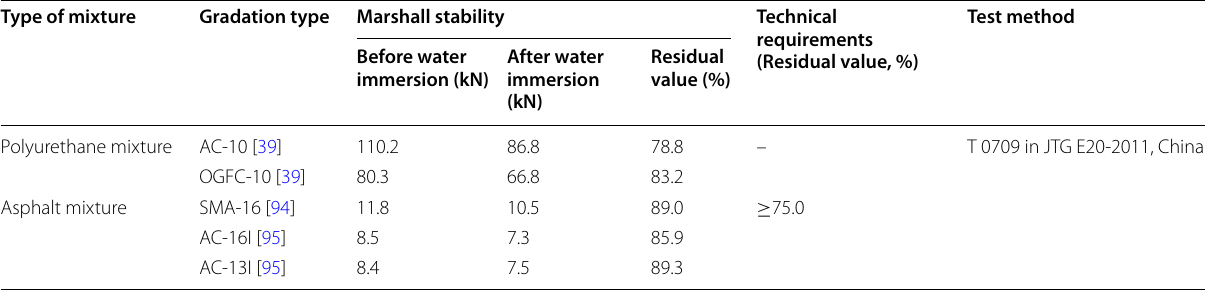
Table 3 The Marshall stability of the polyurethane mixture used for tunnel pavement, compared to the conventional asphalt mixture Type of mixture